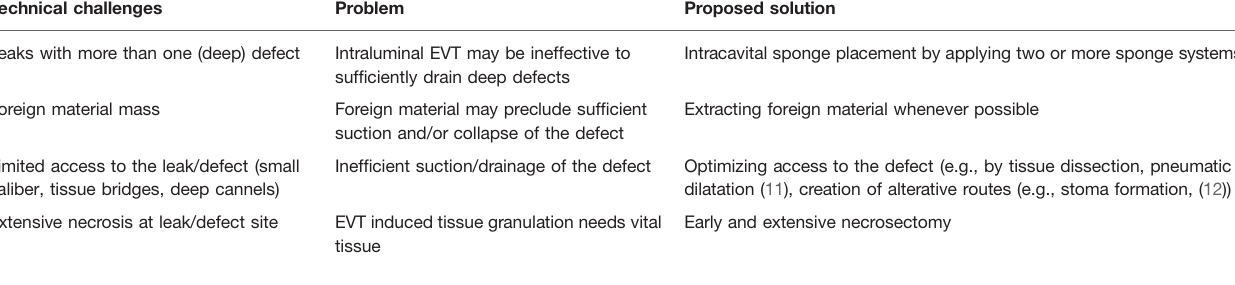
TABLE 3 | Challenging endoscopic situations and proposed